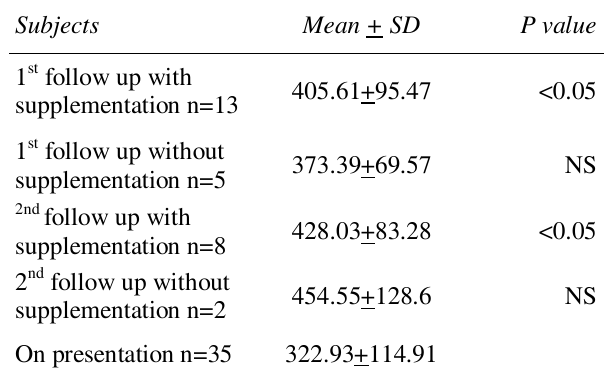
Table 6: Total antioxidant activity level (µmol/L) in marasmus and kwashiorkor with and without antioxidant supplementation during follow up.